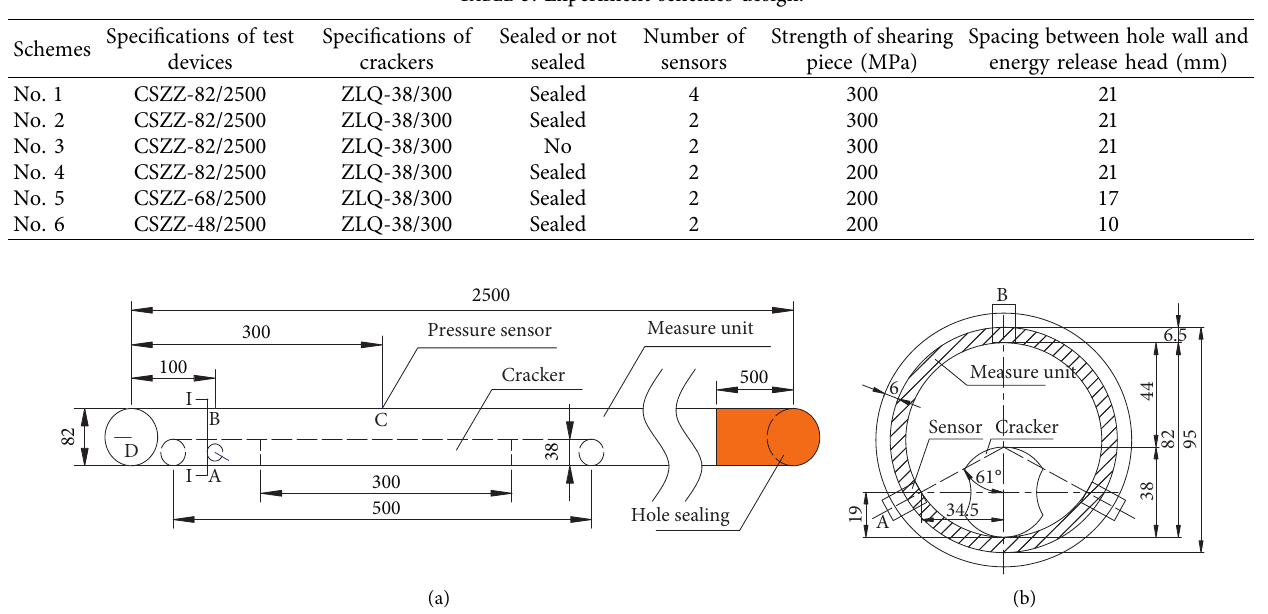
Table 3: Experiment schemes design.